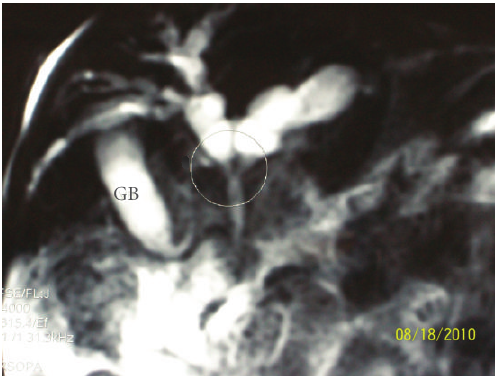
Figure 1: Portal cholangiopathy: this 18-year-old-boy presented with fever and jaundice. He has been treated with endoscopic sclerosis of esophageal varices from the age of six, because of portal hypertension secondary to extrahepatic portal vein obstruction. Cholangio-MRI shows dilated intrahepatic biliary tree, proximal to the level of stenosis (circle). GB: